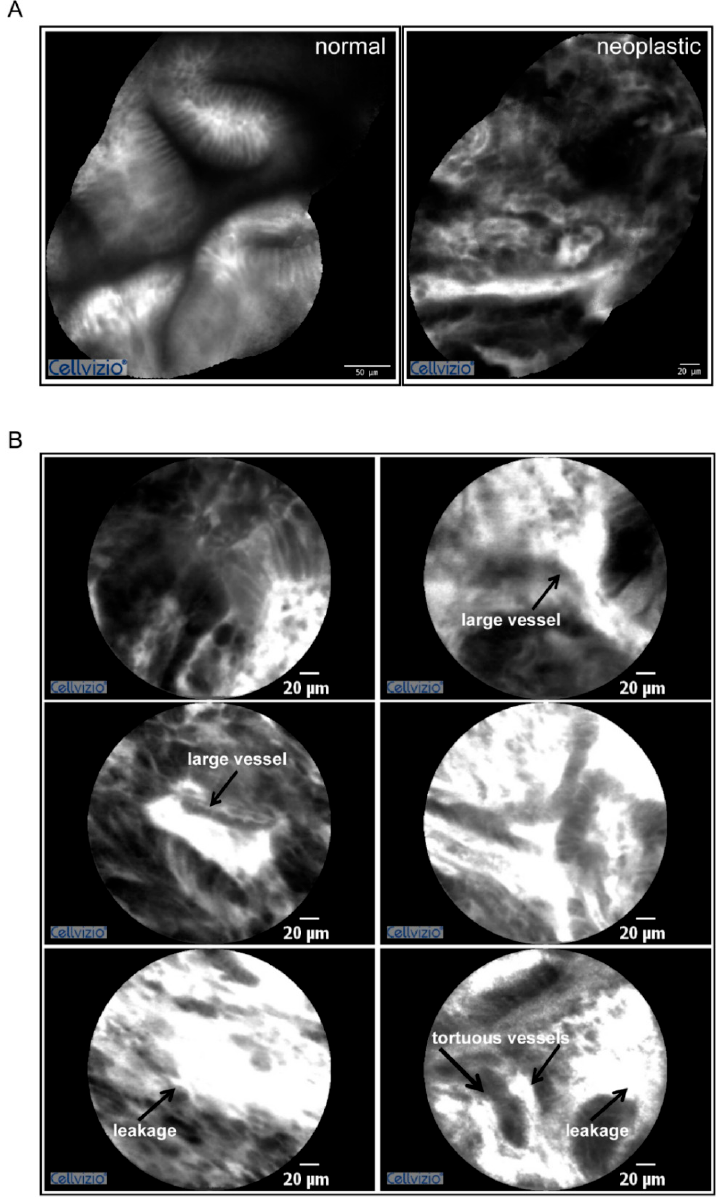
Figure 1. Gastric cancer display a high angiogenic score. ( A ) Mosaic reconstructions of the pCLE analyses of the normal (left) and neoplastic (right) mucosa in a gastric cancer patient characterized by an angiogenic score of 3. ( B ) Representative images captured during pCLE endomicroscopy showing the presence of blood vessels’ leakage, tortuous vessels, and large dilated vessels well detectable in highly vascularized areas. These vessels often display defective blood flow (see Supplemental Video